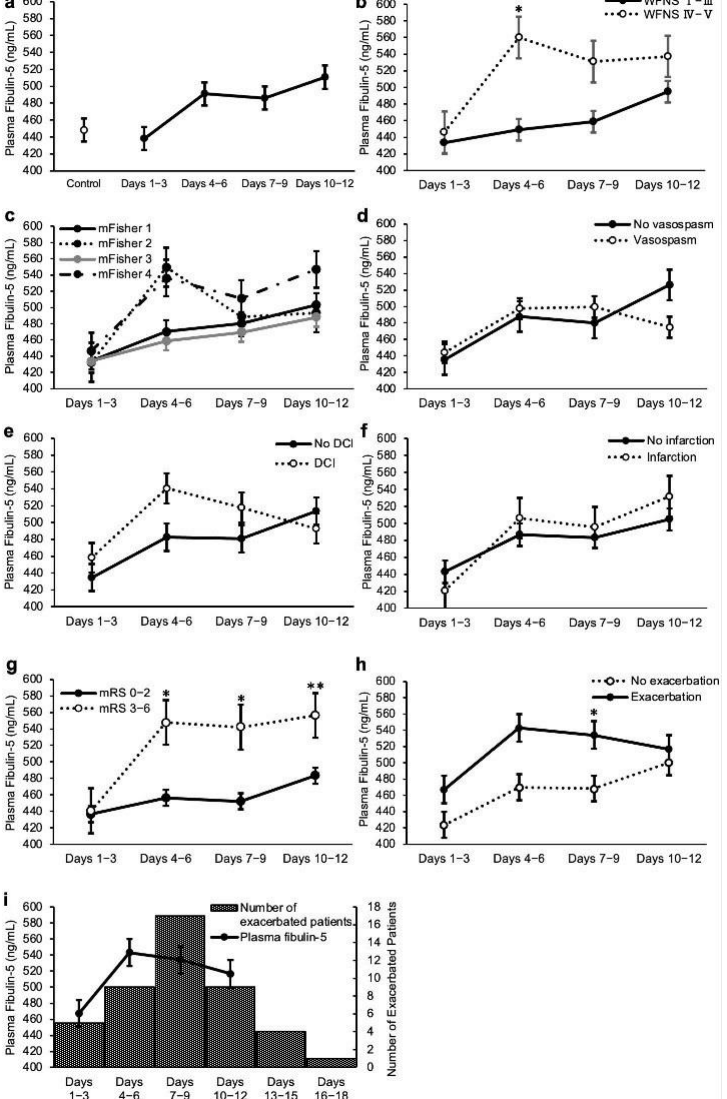
Figure 2. Chronological changes in the plasma fibulin-5 levels after a subarachnoid hemorrhage (SAH). Comparison between the control and SAH patients ( a ), between SAH patients with World Federation of Neurological Surgeons (WFNS) grades I-III and IV-V at admission ( b ), among the modified Fisher grades ( c ), between patients with and without angiographic vasospasm ( d ), delayed cerebral ischemia (DCI); ( e ), or delayed cerebral infarction ( f ), between the 90-day modified Rankin scale (mRS) 0-2 and 3-6 ( g ), and between patients with and without neurological exacerbations ( h ). Relationships between the changes in the plasma fibulin-5 levels and the timing of the neurological exacerbation ( i ). Data, a mean ±standard error of the mean. * p < 0.05, Mann – Whitney U test; ** p < 0.05, unpaired t test.